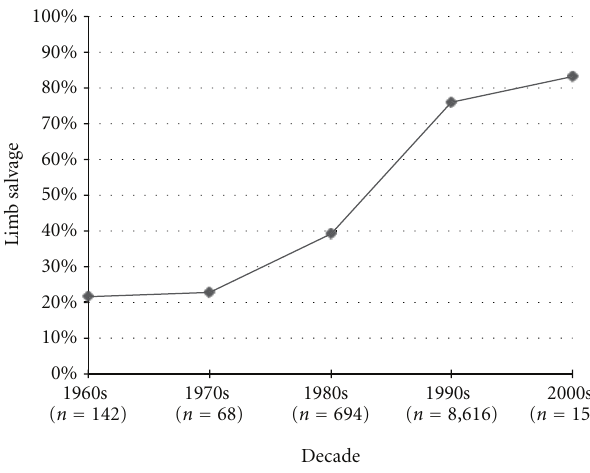
Figure 7: Osteosarcoma limb salvage rates.